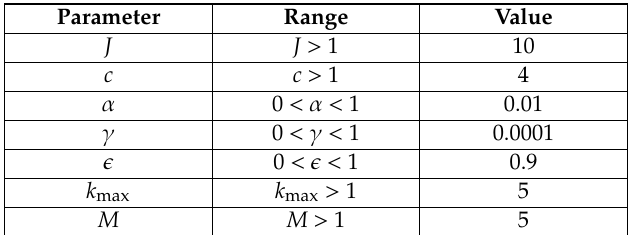
Table 1. The parameters of TRL. TRL: Transfer Reinforcement